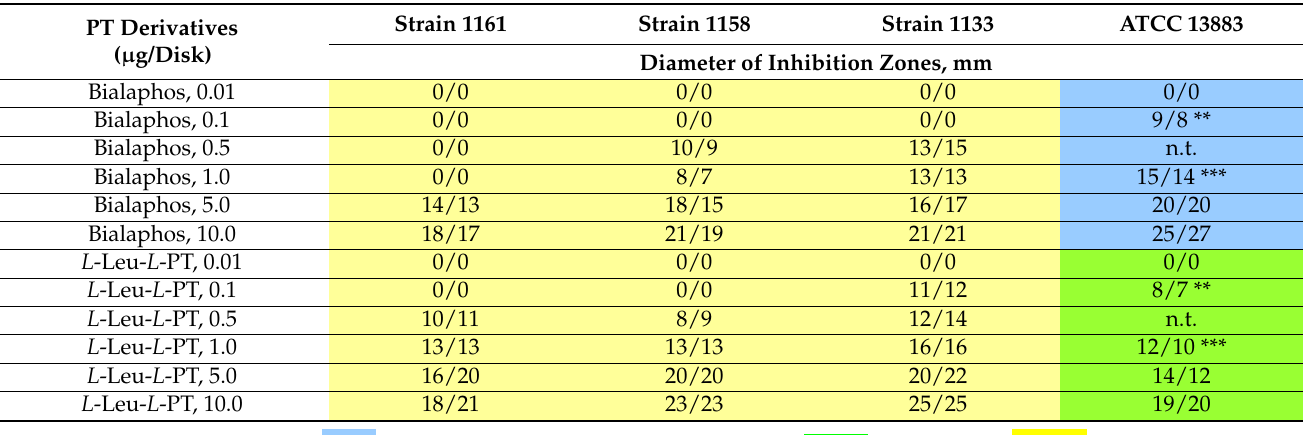
Figure 3. Inhibition of the growth of reference strain Klebsiella pneumoniae ATCC 13883 with L -Leu- L -PT and reverse of the effect with Gln. ( a ) Dose-dependent effect of L -Leu- L -PT, µg/disk; ( b ) same as ( a ), but with the agar containing 0.5 mM Gln. Table 2. Dose-dependent inhibition of the growth of clinical isolates of K. pneumoniae MDR strains 1161, 1158 and 1133 with Bialaphos and L -Leu- L -PT (yellow background); reference strain ATCC 13883 with Bialaphos (blue background) and L -Leu- L -PT (green background). The displayed values from two dishes.